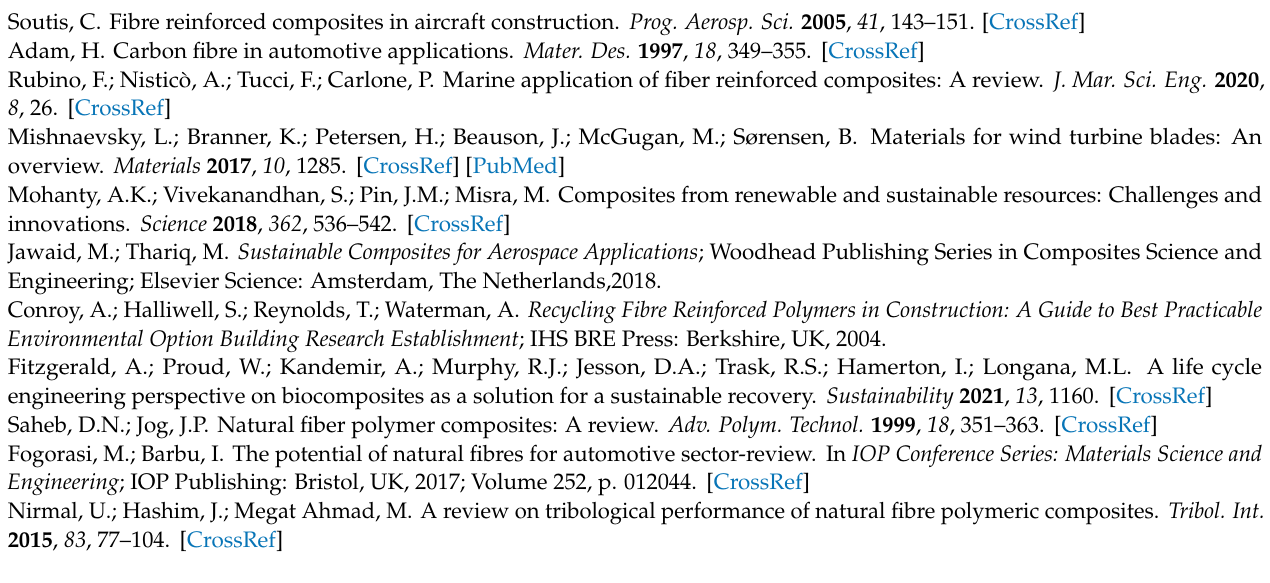
Figure S2: The cross sectional optical images (left column) and the fracture area scanning electron micrographs (right column) of 6 mm curaua aligned discontinuous natural fibre composites. Figure S3: The cross sectional optical images (left column) and the fracture area scanning electron micrographs (right column) of 4 mm flax-cu aligned discontinuous natural fibre composites. Figure S4: The cross sectional optical images (left column) and the fracture area scanning electron micrographs (right column) of 2 mm flax-ft aligned discontinuous natural fibre composites. Figure S5: The cross sectional optical images (left column) and the fracture area scanning electron micrographs (right column) of 4 mm jute aligned discontinuous natural fibre